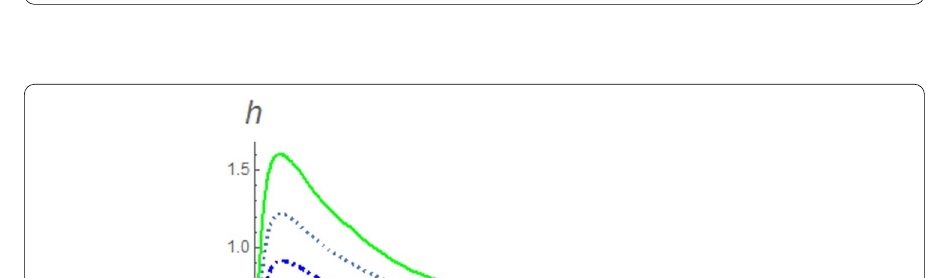
Fig. 2 Effect of H g on the velocity profile